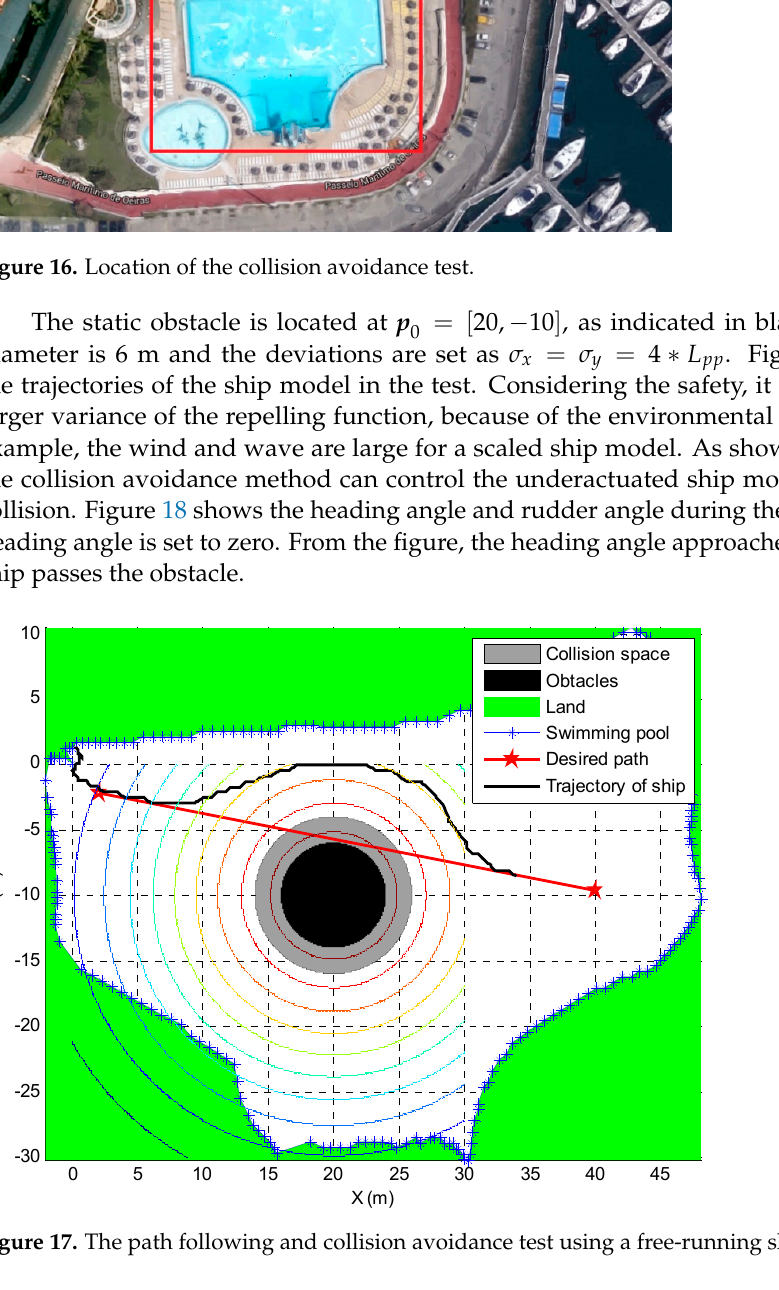
Figure 18. Heading angle and rudder angle during the test.